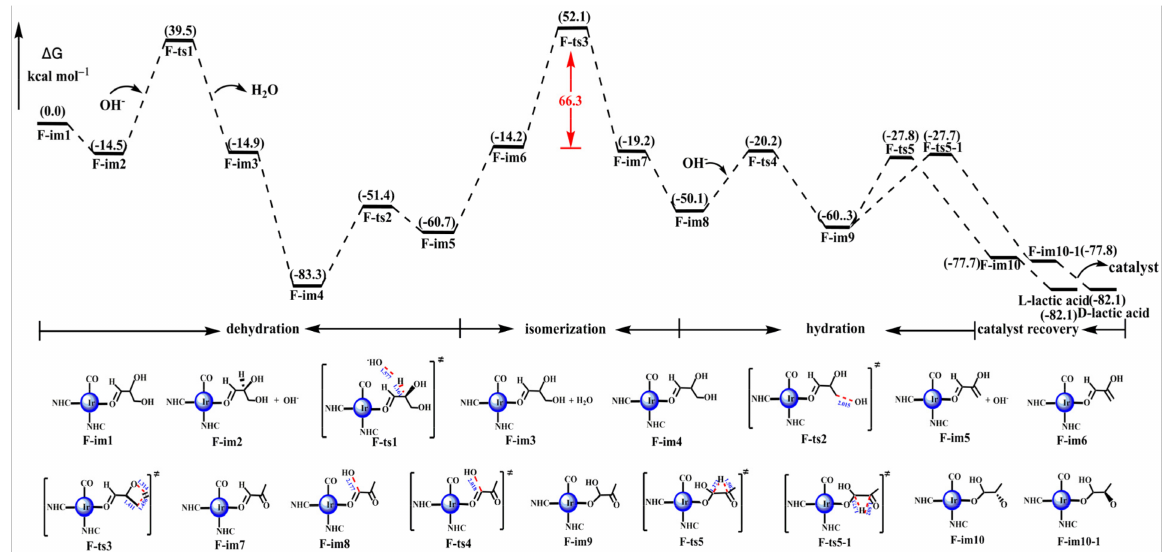
Figure 4. Energy profile for the dehydration and hydration reaction of 2,3-dihydroxypropanal to lactic acid catalyzed by the iridium–NHC with the free hydroxide. Next, the hydroxide attacked the terminal carbonyl group of pyruvic aldehyde (F-im8) to form F-im9, and then it was converted to lactic acid through a proton-migration process. Finally, a molecule of lactic acid was released, and the iridium–NHC catalyst was